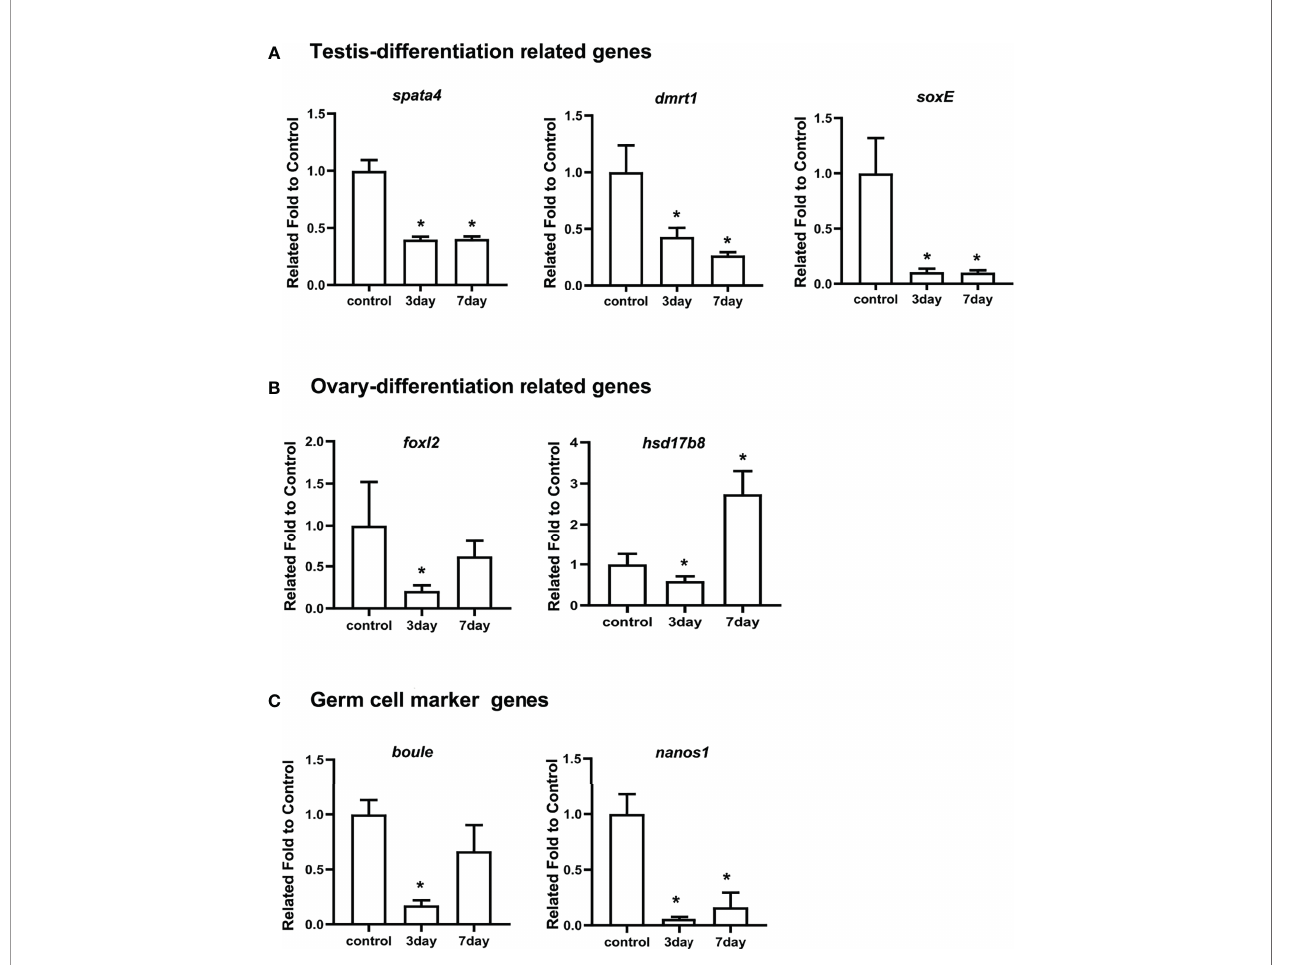
FIGURE 4 | RT-qPCR measured the mRNA levels of spata4 and other sex-related genes after RNAi. (A) The expression of testis differentiation genes, including spata4 , dmrt1 , and soxE . (B) The expression of ovary differentiation genes, including foxl2 and hsd17b8 . (C) The expression of germ cell marker genes, including boule and nanos1 . 18S was used as the control. The gene expression in the control group was set to 1. Each bar represents mean ± standard deviation (SD) from three individuals. Independent-sample t -test was used to perform statistical analysis. Asterisks (*) indicate signi fi cant differences ( p ≤ 0.05) between knockdown and